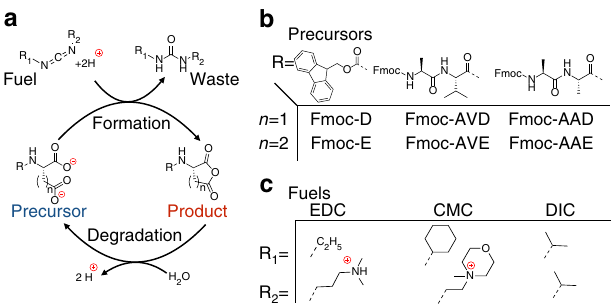
Figure 1 | Transient anhydride formation by carbodiimide fuels. ( a ) Scheme of the chemical reaction network for the fuel driven formation of a transient anhydride bond. ( b ) Molecular structures of the dicarboxylates precursors used in this study. ( c ) Molecular structures of the fuels used in this